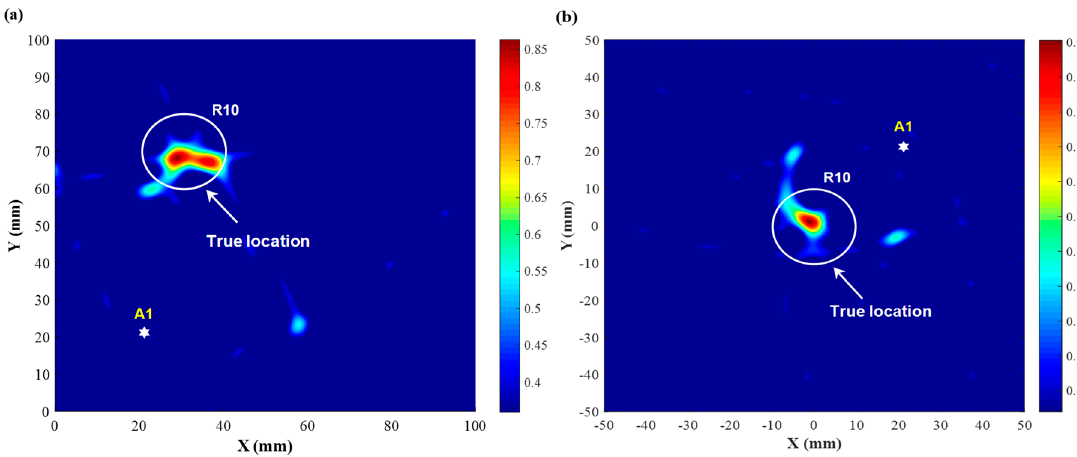
Figure 12. Diagnostic image obtained using the ToF-based PDI algorithm with a threshold value: ( a ) damage at (30 mm, 70 mm); ( b ) damage at (0, 0).